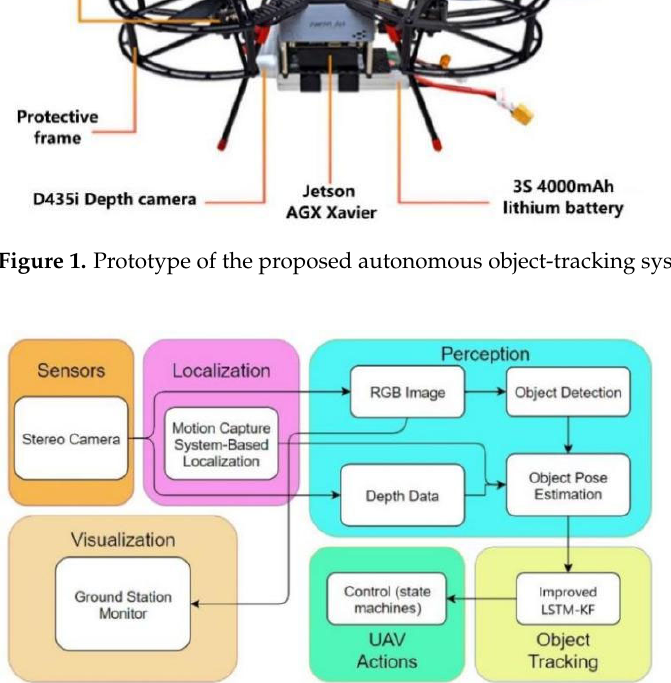
Figure 1. Prototype of the proposed autonomous object-tracking system.